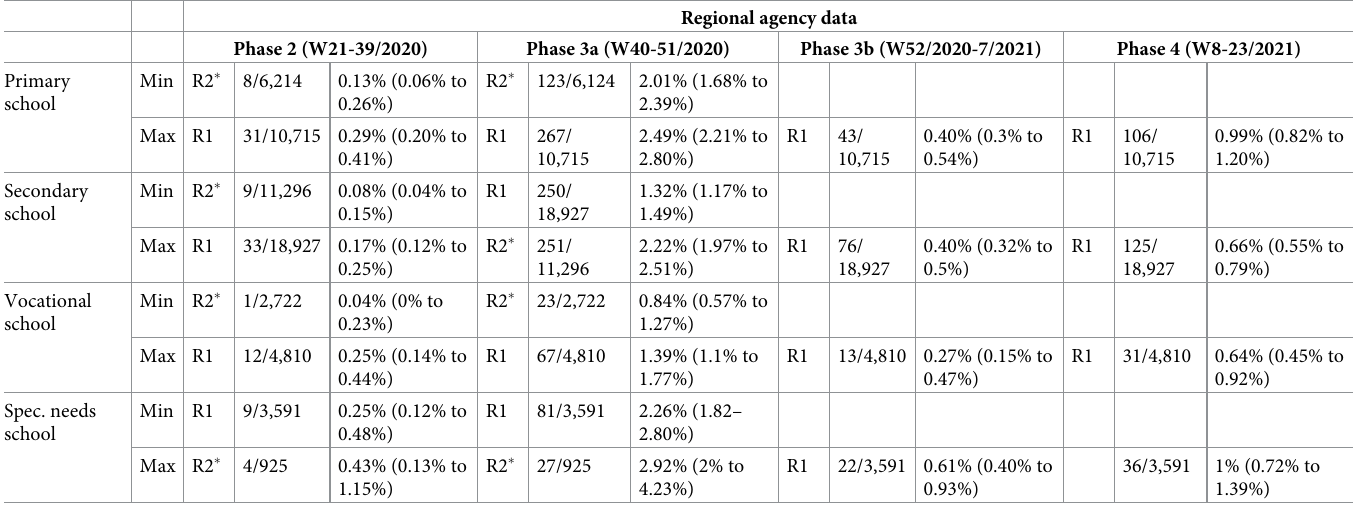
8.8 times more secondary cases originated in households relative to